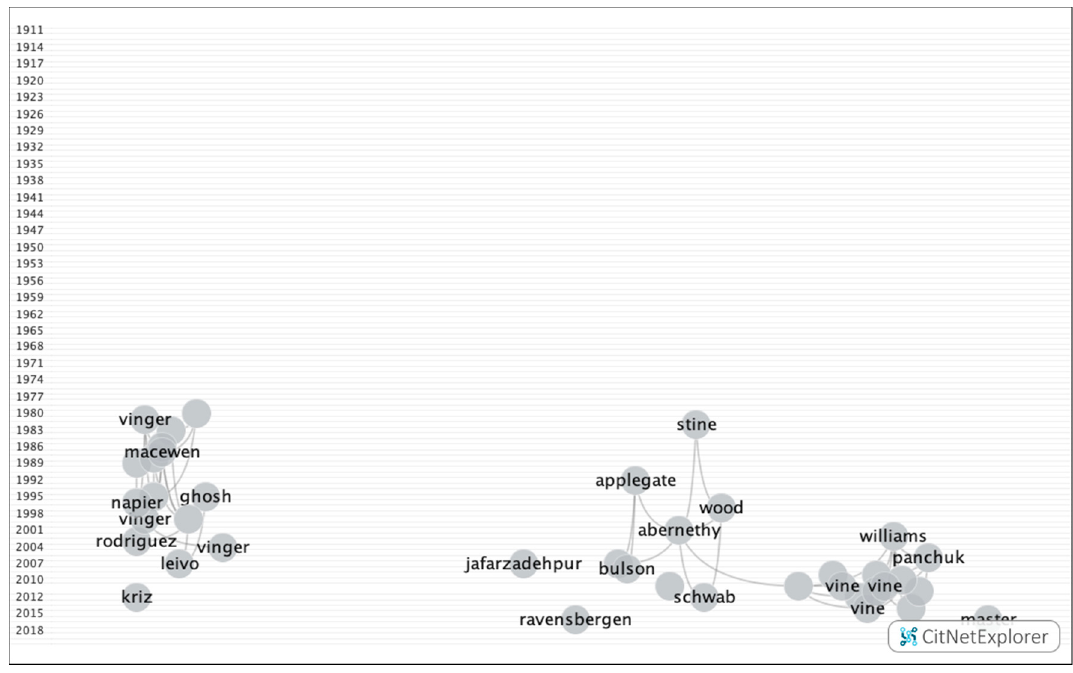
Figure 1. Citation networks on sports vision.